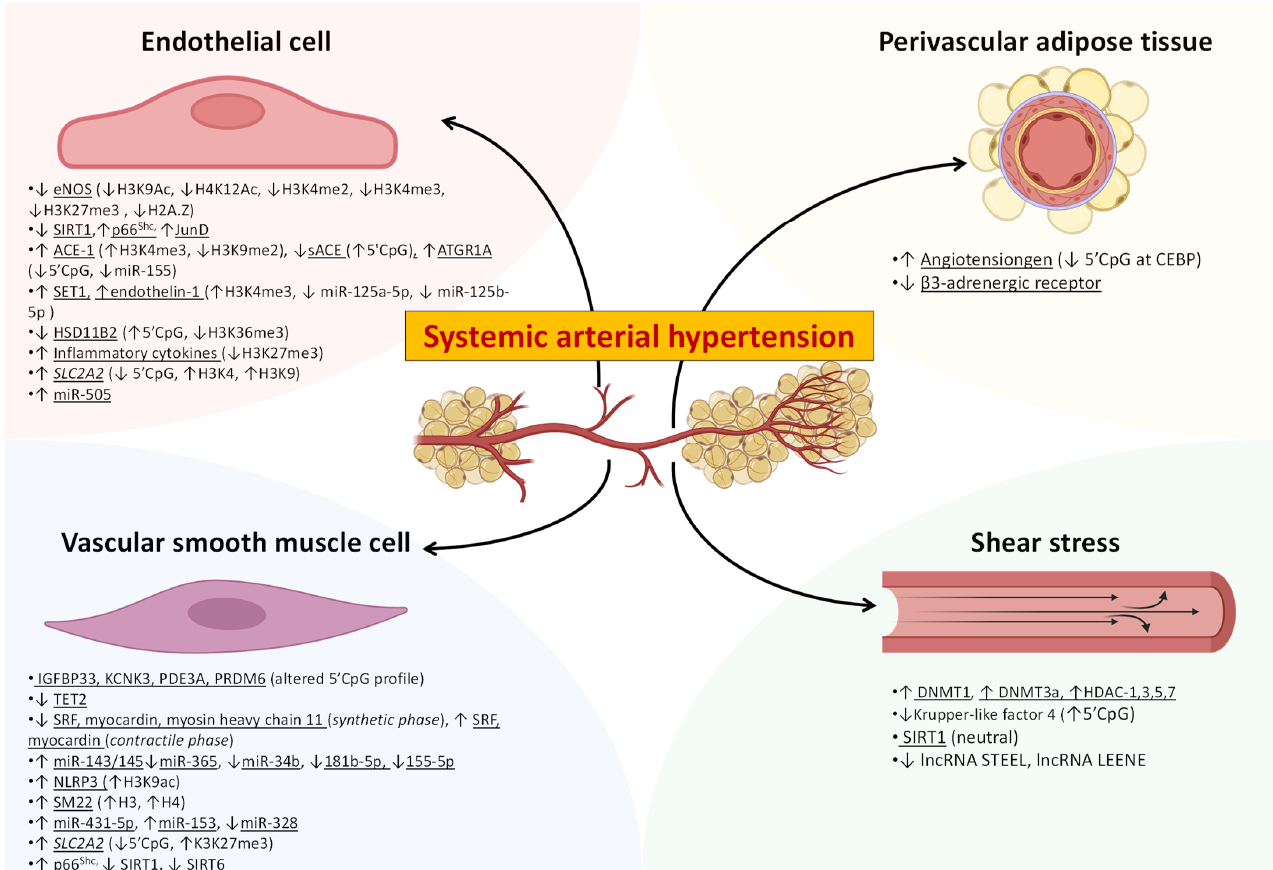
Figure 1. Epigenetic crosstalk of the microvascular unit in the context of hypertension. In systemic arterial hypertension, the four major elements of the microvascular unit (endothelial cells, vascular smooth muscle cells, perivascular adipose tissue and shear stress) possess a unique epigenetic signature that hinders the efficacy of the most recently developed drugs targeting hypertension. Future studies should address the complex network of epigenetic interaction and crosstalk underpinning